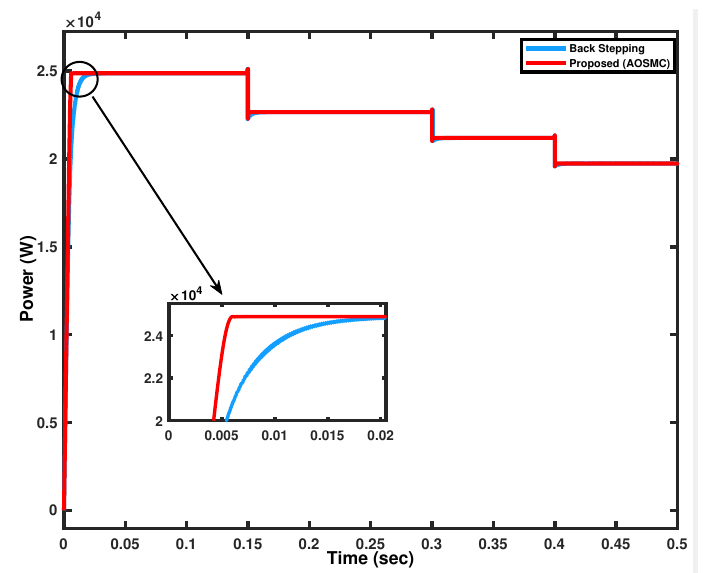
Figure 20. Comparison of the generated output power under varying